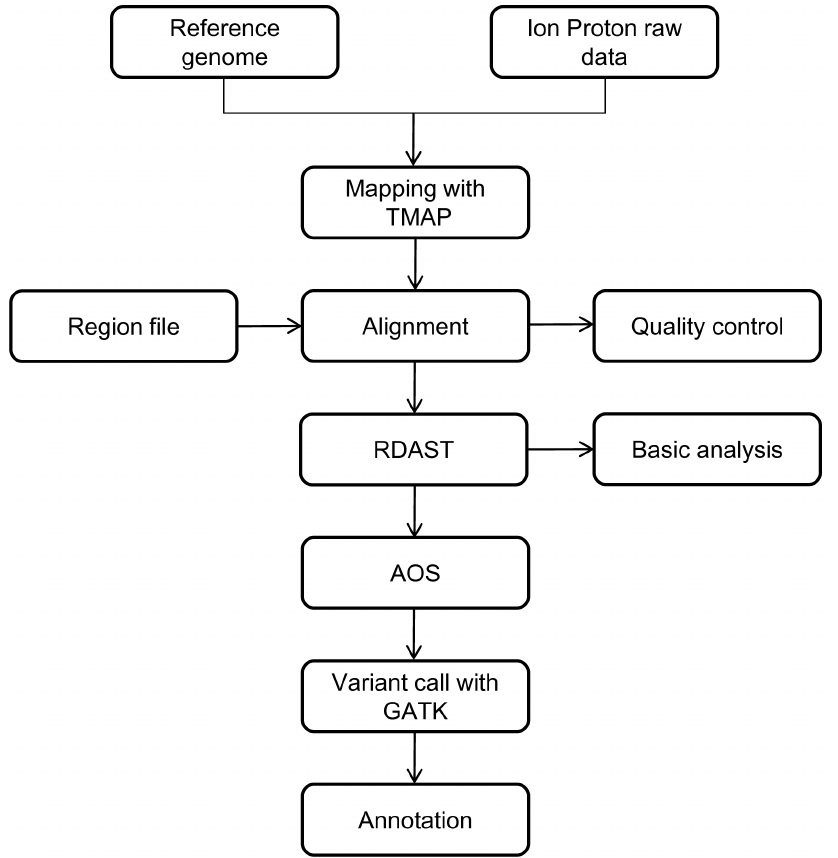
Figure 1. Pipeline of OTG-snpcaller.